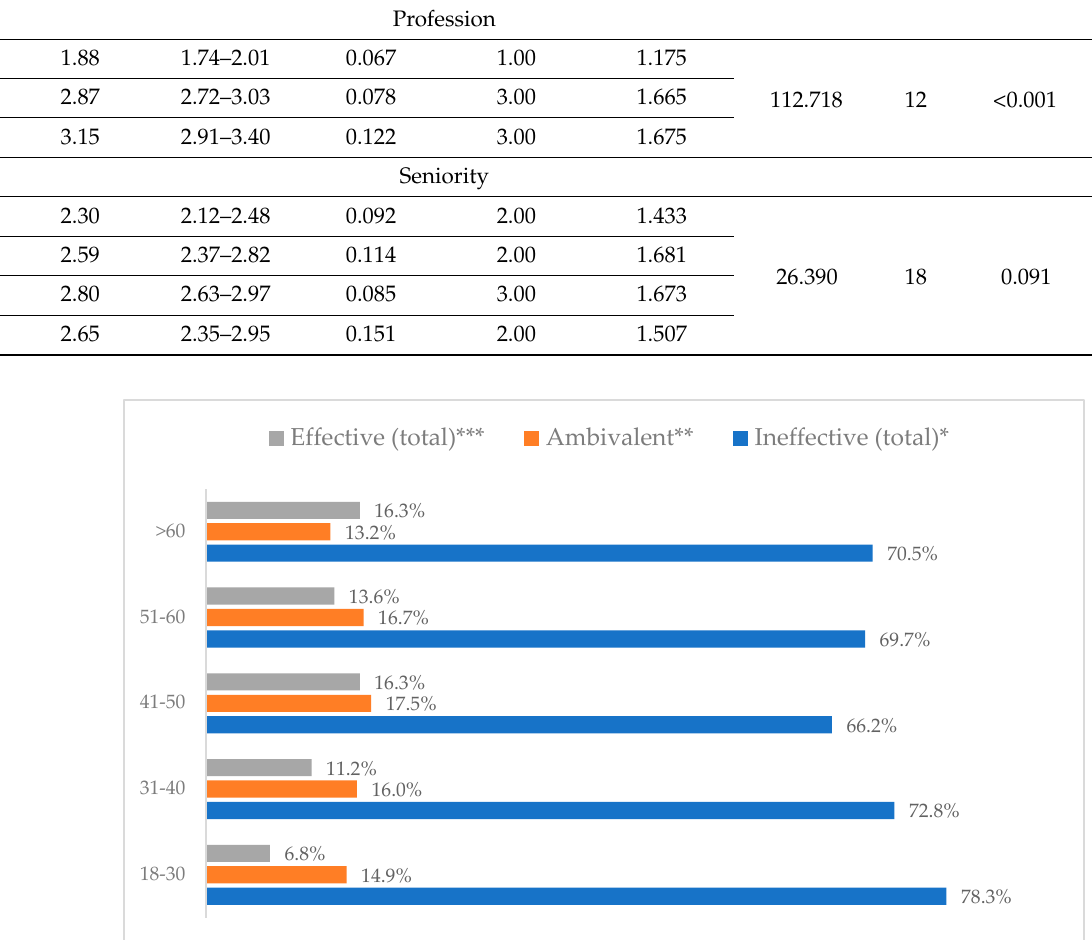
Figure 28. Taking preparations with inosine to prevent influenza virus infection by type of hospital ( N = 905). *Sum of responses: completely ineffective, ineffective, rather ineffective; **Response: nei- ther ineffective nor effective; ***Sum of responses: rather effective, effective, completely effective.